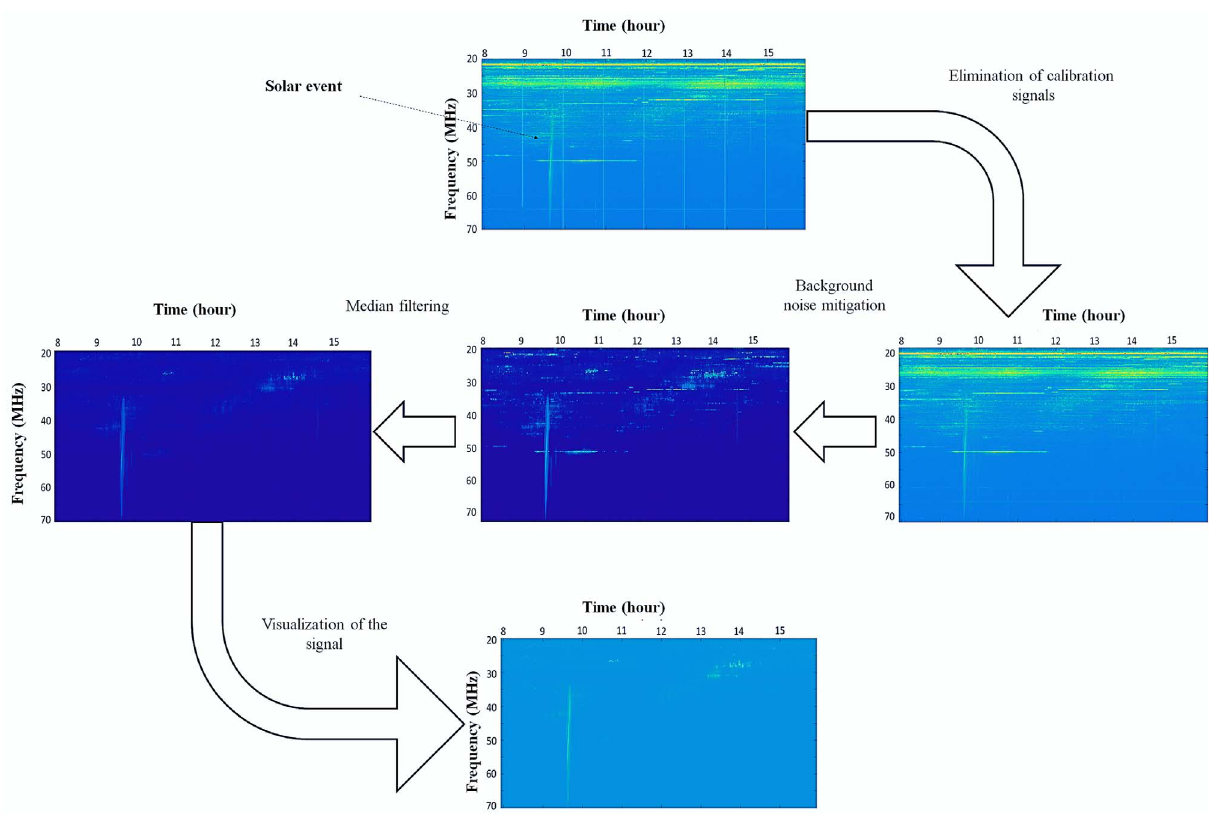
Fig. 8. Example showing the dynamic spectrum obtained at each step of the calibration and background noise removal